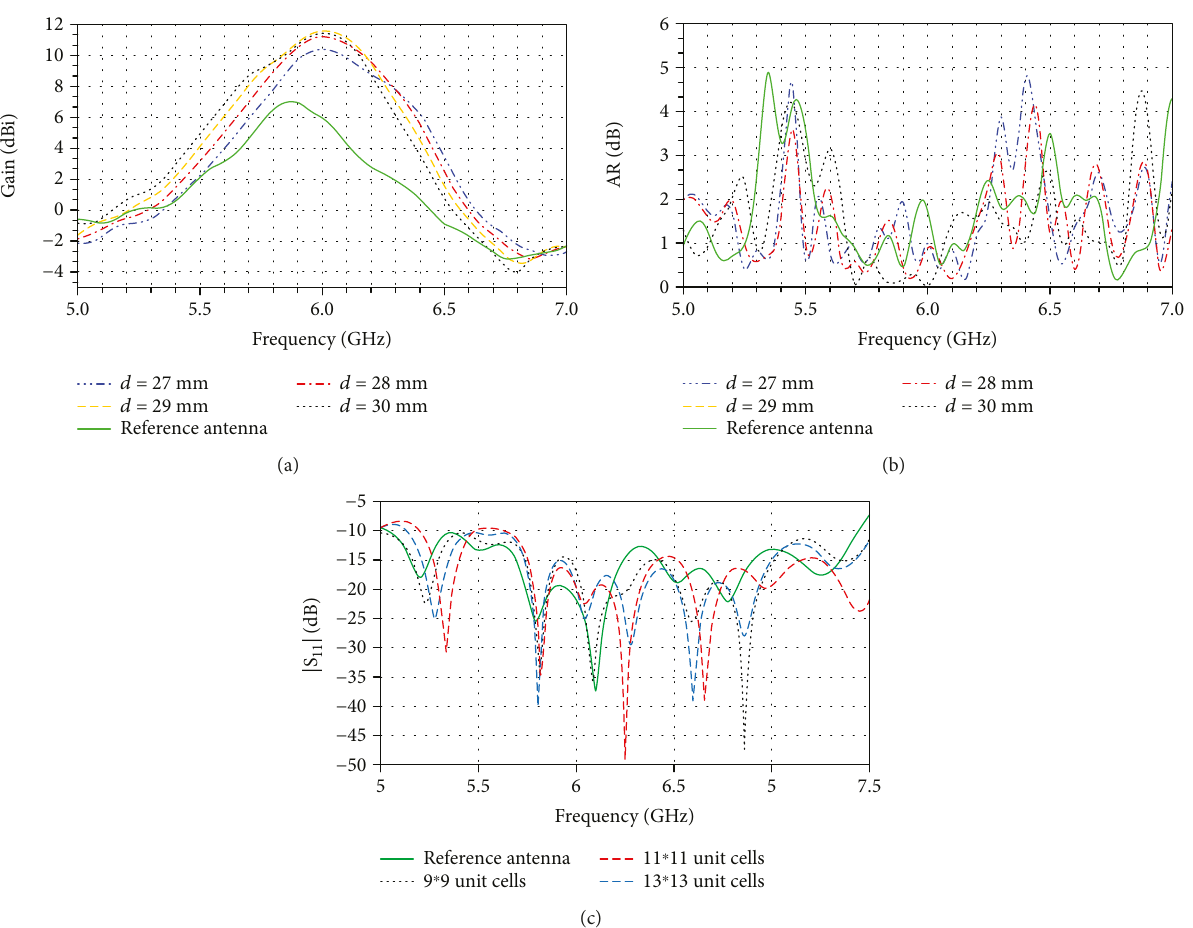
Figure 5: (a) Gain of reference antenna with and without WBLHM layer at di ff erent distances d . (b) Axial Ratio (AR) of reference antenna with and without WBLHM layer at di ff erent distances d . (c) Re fl ection coe ffi cient of reference antenna with and without WBLHM layer using various number of unit cells.